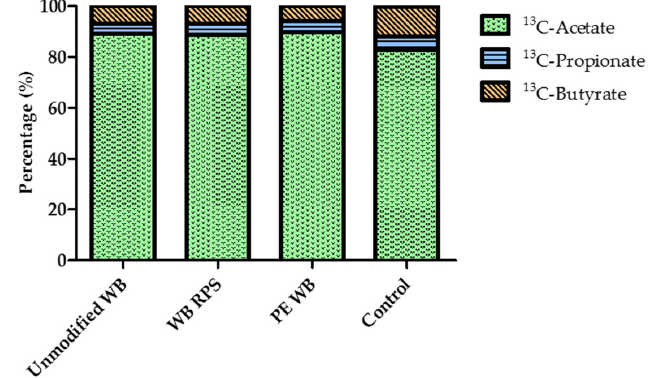
Figure 9. The proportions of 13 C-acetate, 13 C-propionate, and 13 C-butyrate in plasma were not affected by wheat bran (WB) ( n = 10).